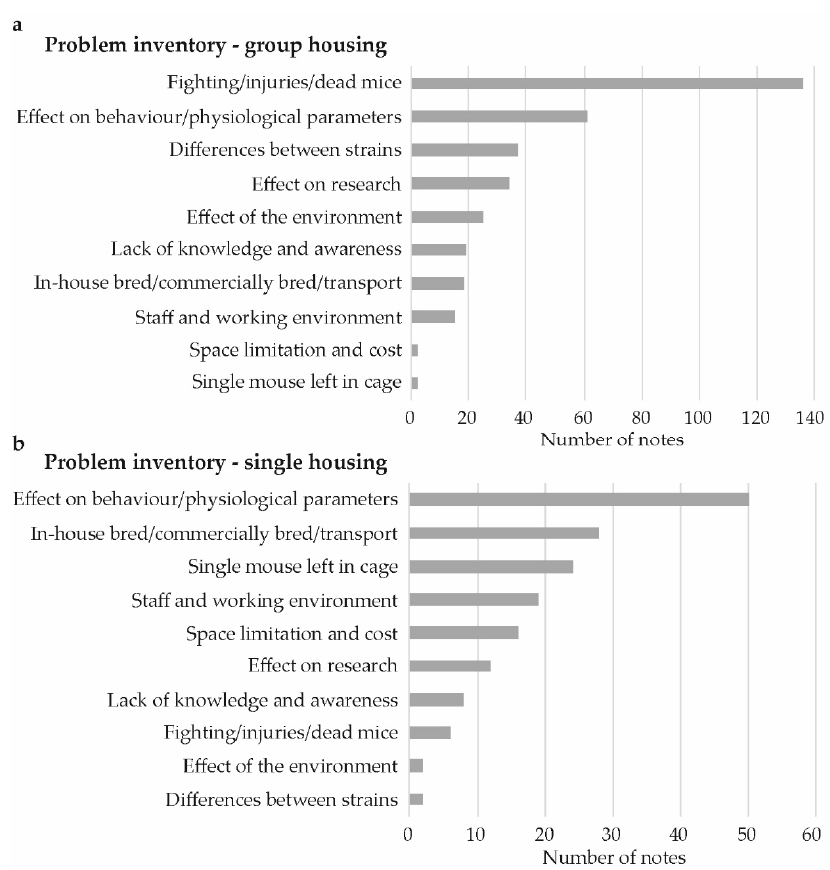
Figure 1. Problem inventory for group- and single-housed male mice. Number of comments